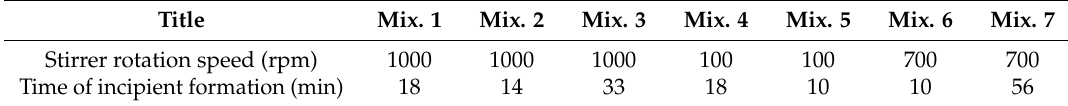
Figure 4. Photos showing different steps during gas hydrate formation and dissociation with Mixture 2. From left to right: ( A ) after H 2 O injection (L H2O -L CO2 ); ( B ) just after incipient formation start (H-L H2O -L CO2 ); ( C ) ca. 40 min after formation start (H-L H2O -L CO2 ); ( D ) ca. 170 min after formation start (H-L H2O -L CO2 ). Table 6. Incipient gas hydrate time of formation on the CH 4 -CO 2 -H 2 O ternary system.